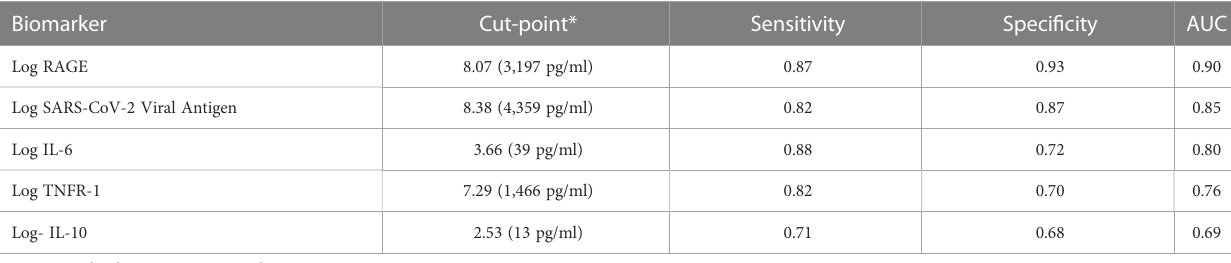
TABLE 4 Sensitivity and speci fi city of key biomarkers on presentation for predicting development of severe disease or death at 7 days using Youden index and cut-point analysis. Biomarker